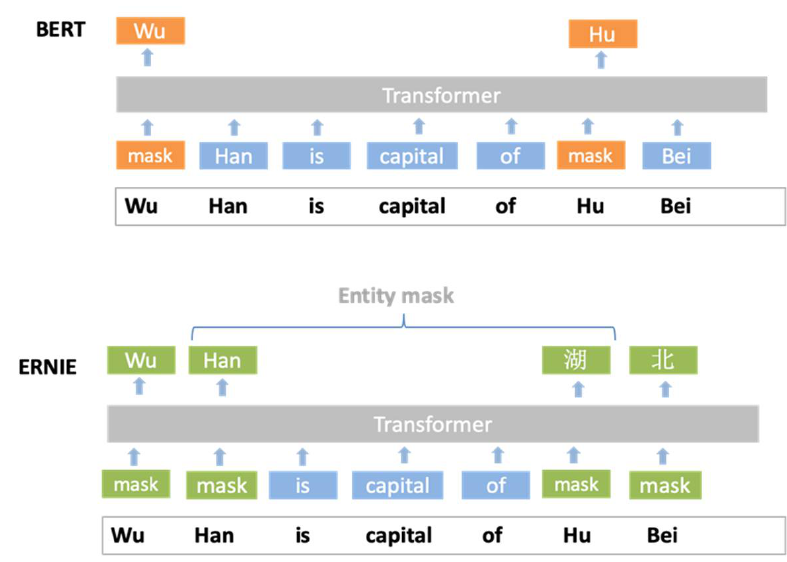
Figure 4. BERT and ERNIE mask mechanism.